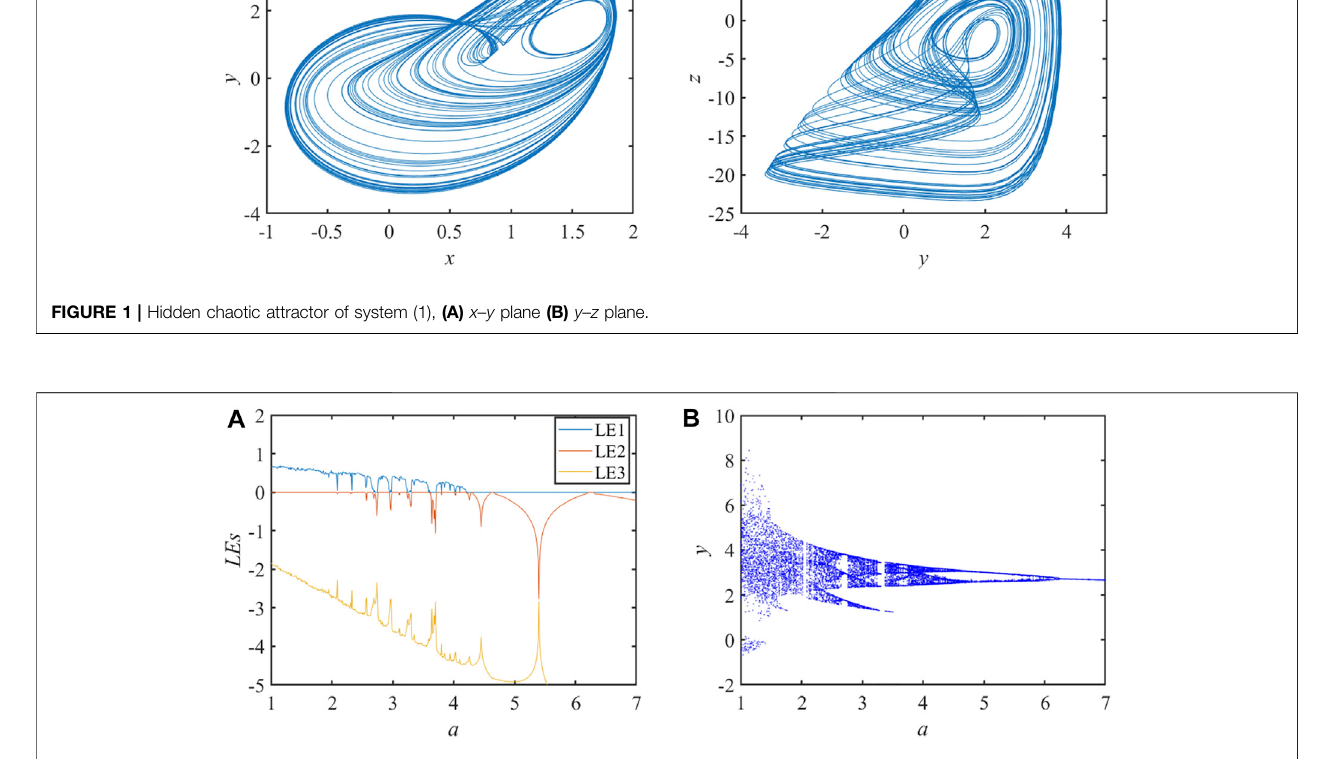
FIGURE 2 | Dynamical analysis with parameter a , (A) LEs, (B) BD.